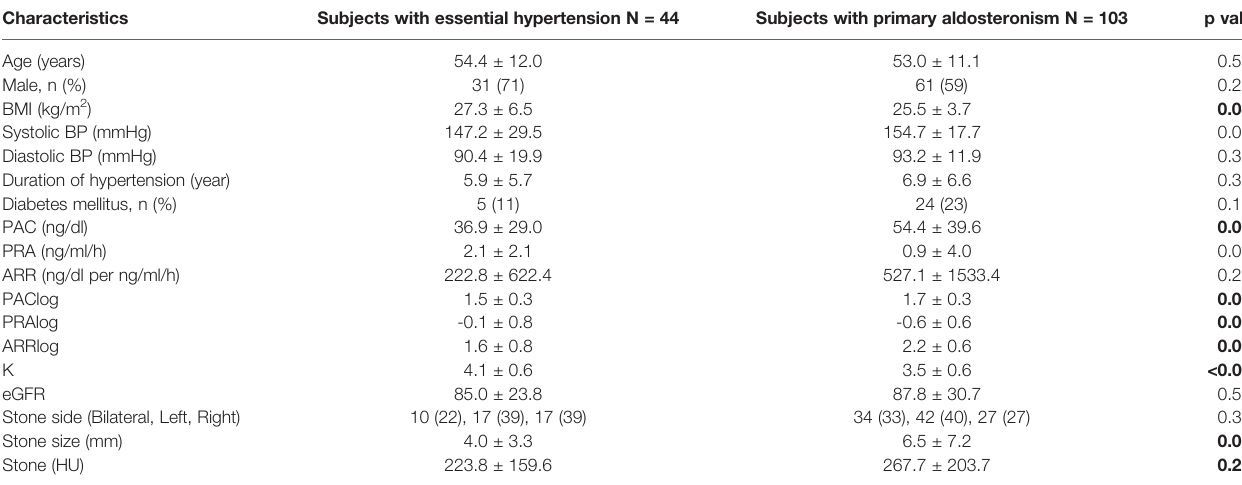
TABLE 2 | Demographic and clinical characteristics of the subjects with kidney stone disease divided by essential hypertension and primary aldosteronism.